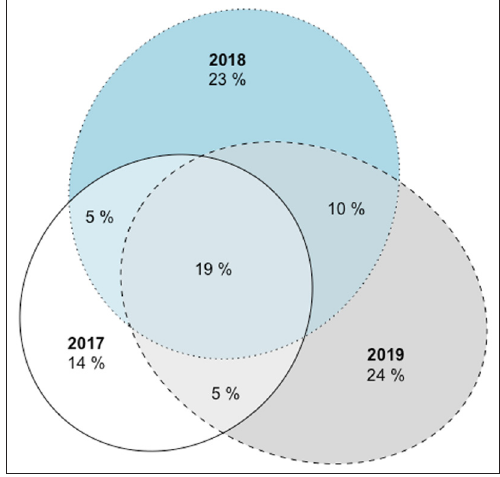
Figure 3 Venn diagram of the uniqueness and commonality of the species found across years 2017–2019. A total of 202 species were identified from the 3 student orientation programs. The number of species common to all 3 years was 39 (19%). The species unique to each year varied from 14% to 24%.